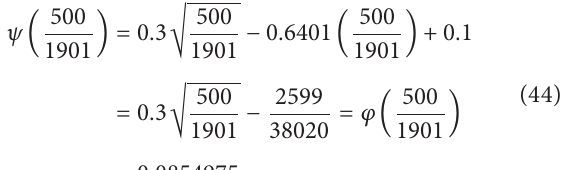
on [0, 500/1901] . It is not hard to see that 𝜓 is an increasing 2 ] function on [0, (0.15/0.6401) and 𝜓 is a decreasing function on [(0.15/0.6401) 2 , 500/1901] . Notice that the starting point 𝑦 = 0 provides the value 𝜓(0) = 0.1 (> 𝜑(500/1901) ≈ 0.0854975) and then it implies that the end point 𝑦 = 500/1901 provides the absolute minimum